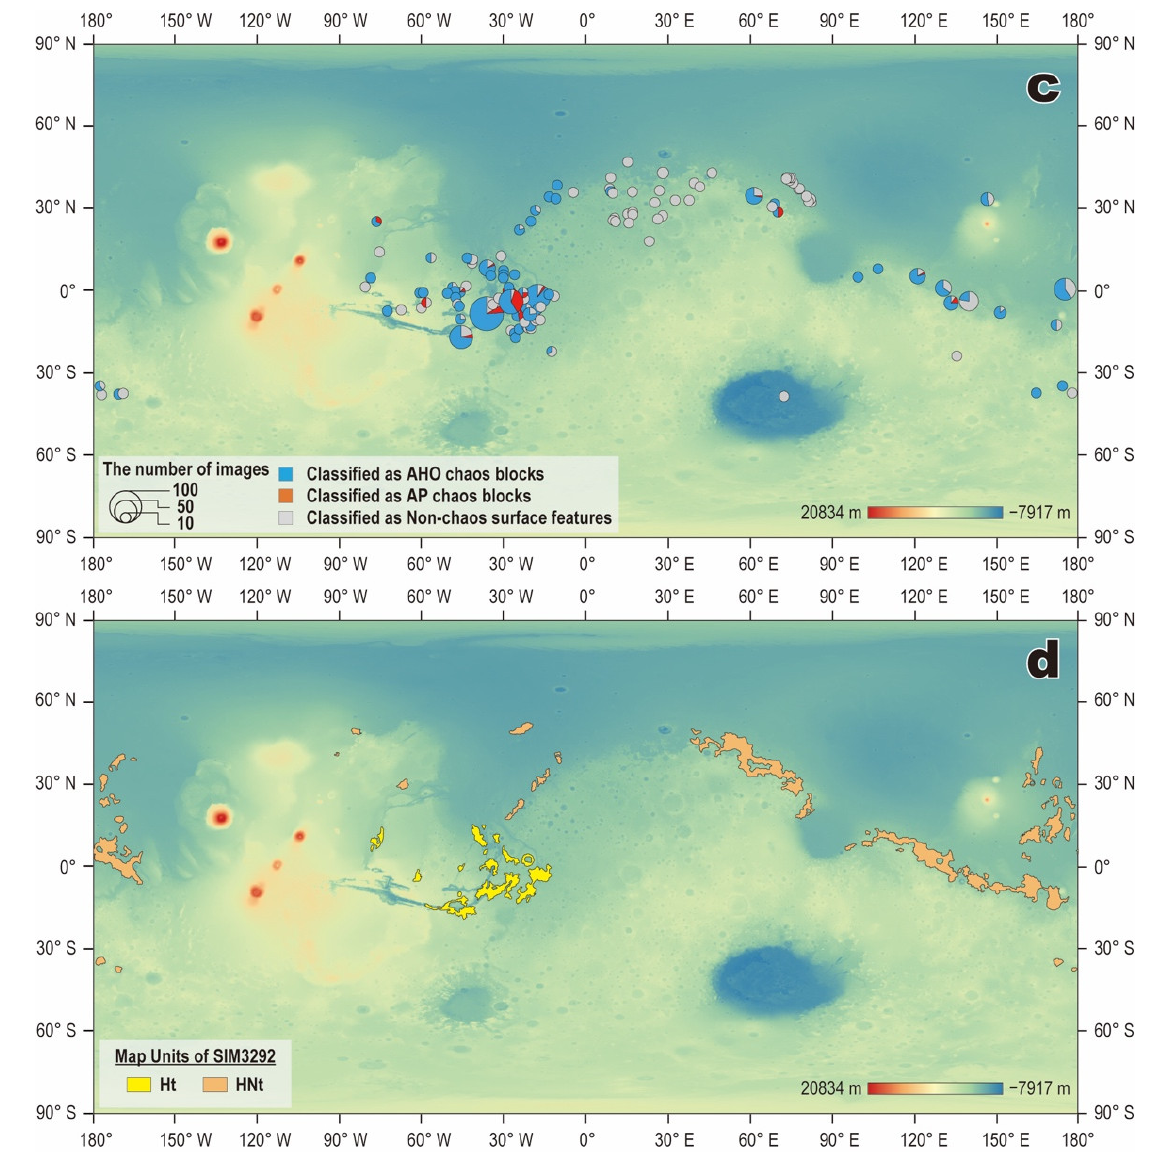
Figure 7. Global distribution of the classified chaos blocks based on ( a ) the CTX classifier, ( b ) the THEMIS classifier, and ( c ) the MOLA classifier superimposed on a Martian topographic map. The pie charts represent the fractions classified in each category. The sizes of the pie charts represent the number of images at a given location. In panel ( a ), the locations of the images used in Figures 9, 10, 13, and S9–S14 are shown. Panel ( d ) shows the global map of chaotic terrain units recognized by geology specialists [24] for comparison. The yellow and orange areas represent the chaotic terrain units on the Hesperian transition unit (Ht) and on the Hesperian and Noachian transition unit (HNt), respectively.